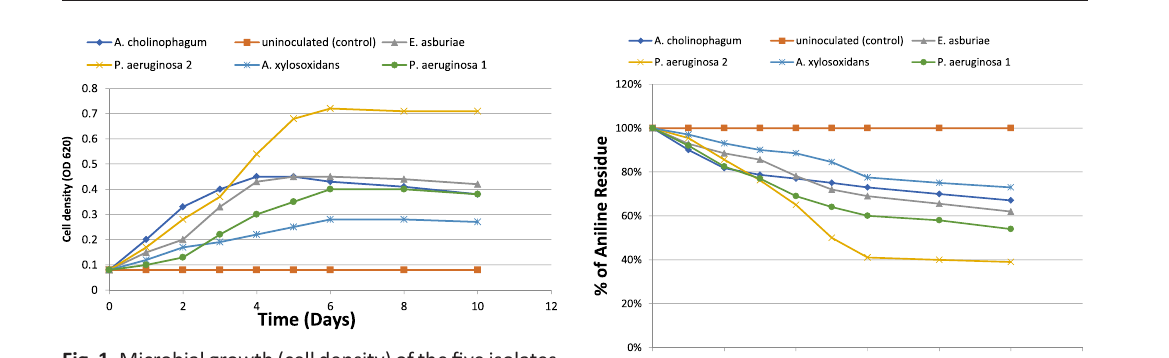
Fig. 1. Microbial growth (cell density) of the five isolates during aniline biodegradation using it as a sole carbon source (f&) and uninoculated (control) (%). Fig. 2. Percentage of aniline biodegradation by the